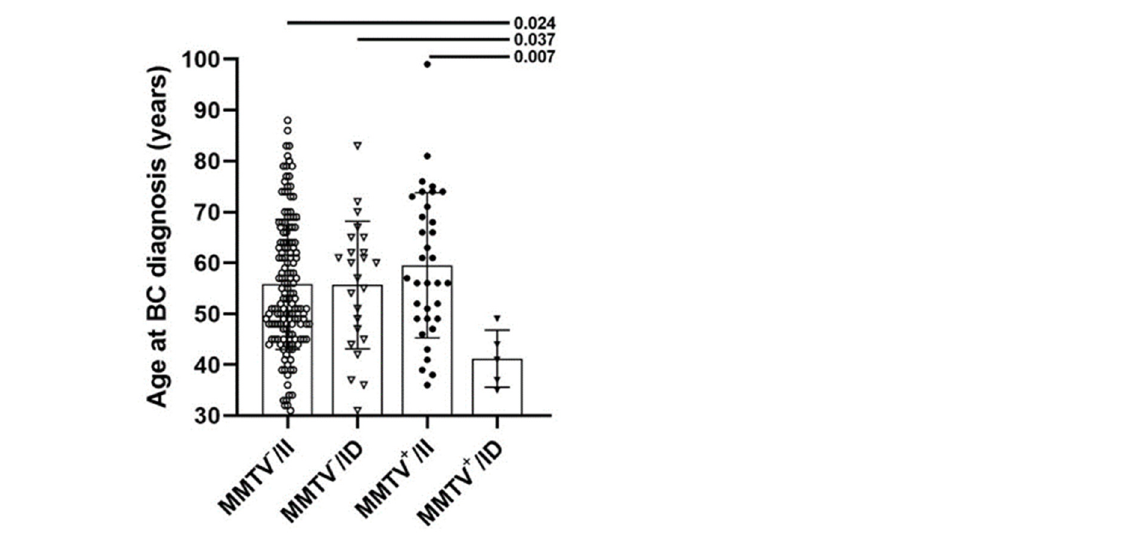
Figure 2. Age comparison between patients’ groups defined by APOBEC3A/B deletion and MMTV-like positivity. Patients carrying both MMTV-like env positivity and APOBEC3A/B deletion (MMTV+/ID) have the lowest age compared to other groups. Each point represents a single patient. Bars represent mean and standard deviation. p -values for Dunn’s post-test are shown.